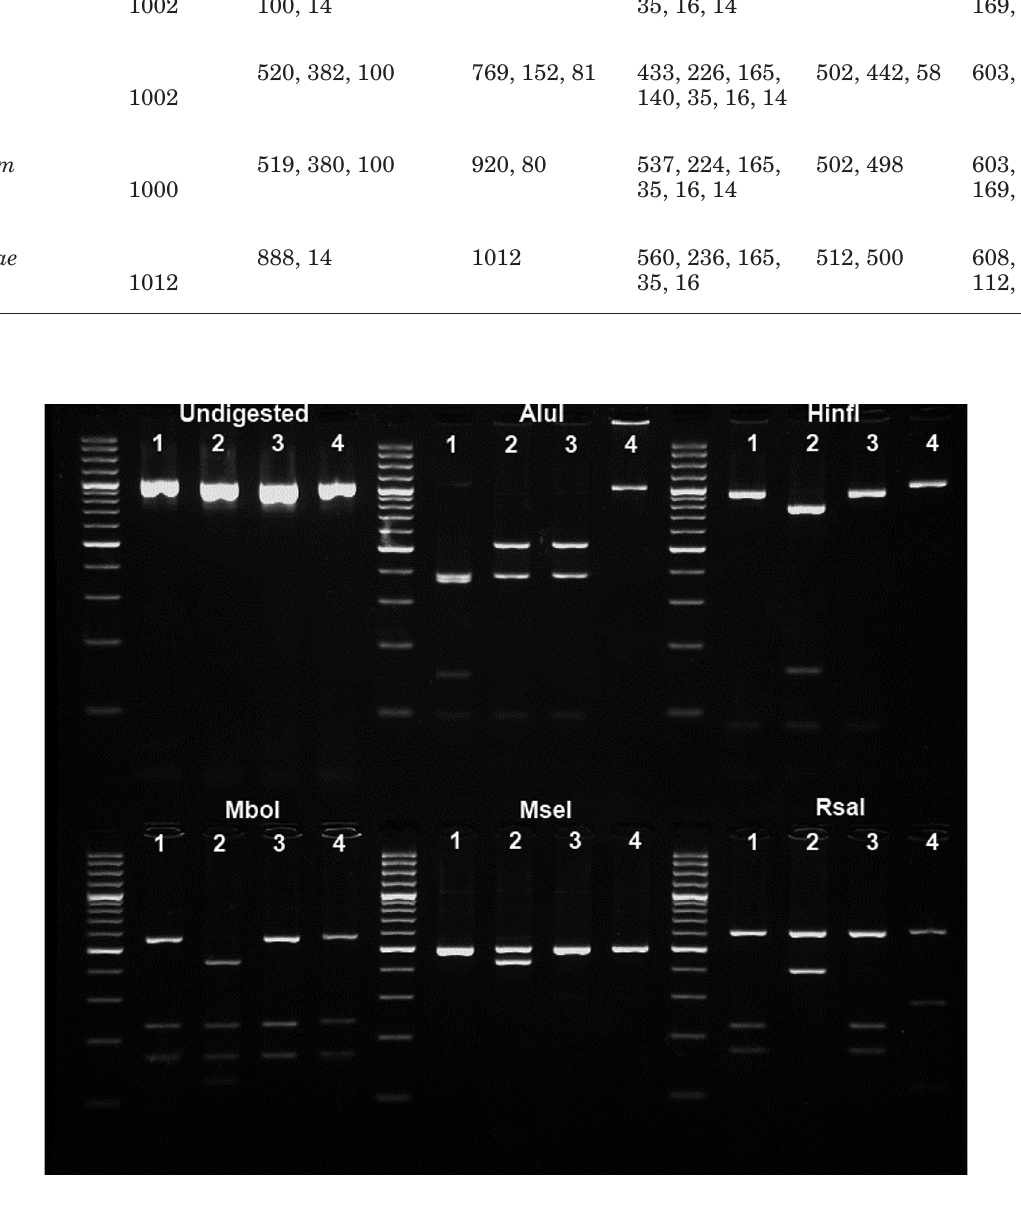
Figure 2. Agarose gel with PCR-RFLP patterns of Globodera rostochiensis (1), G. pallida (2) , G. tabacum (3) and G. achilleae (4). DNA ladder 100 bp Plus (Fermentas GMBH, Germany), restriction enzymes used: Alu I, Hinf I , Mbo I, Mse I, and Rsa